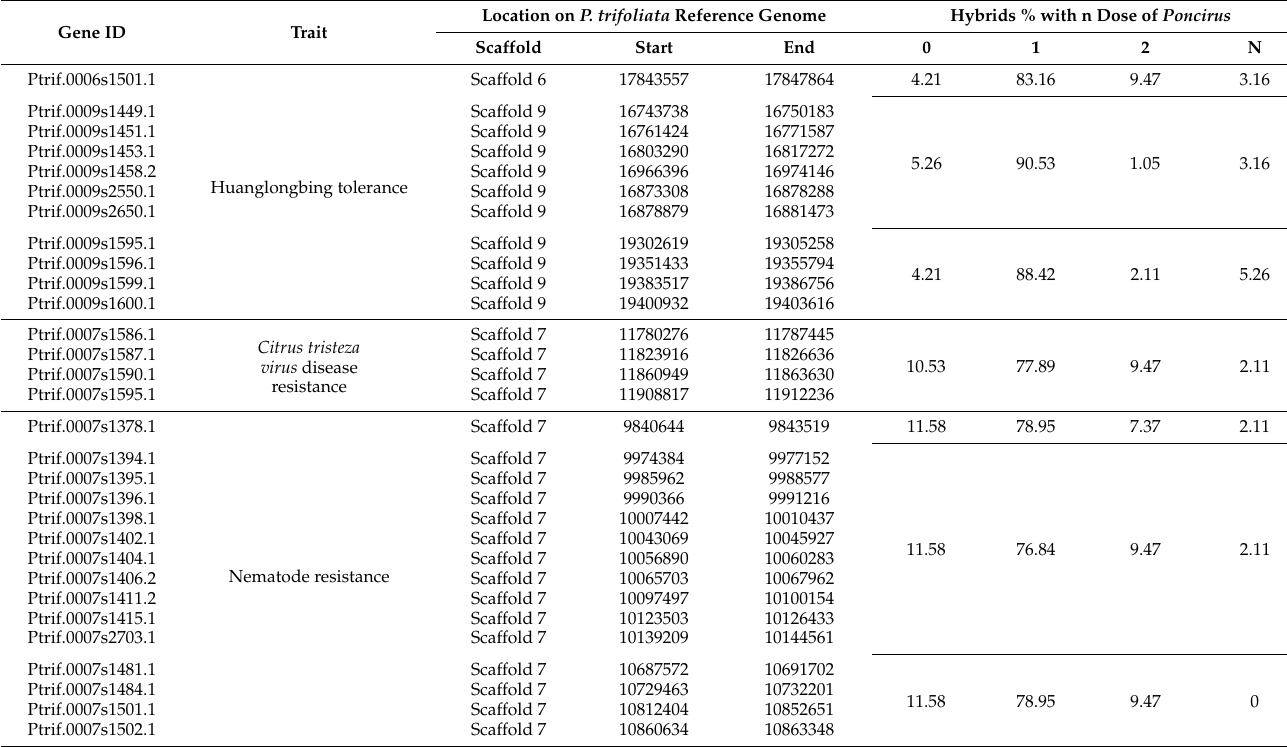
Table 5. Inheritance in the hybrids population of candidate genes (according to Peng et al., 2020, [58]) located in the P. trifoliata reference